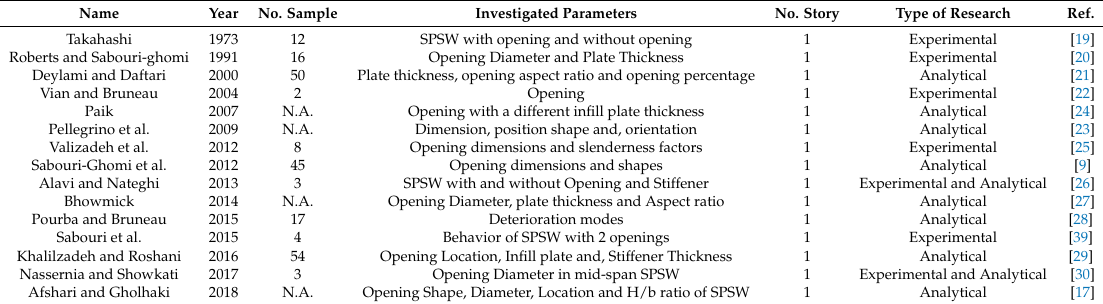
Table 1. A summary of the researches about the effects of openings on steel plate shear walls